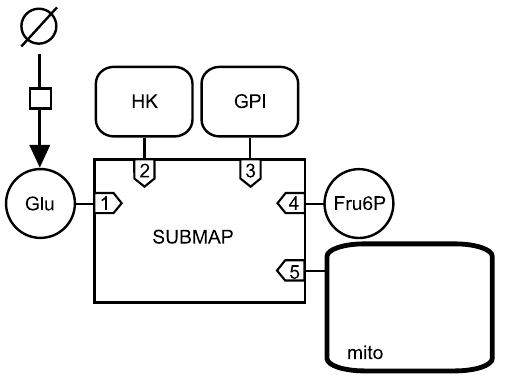
Figure 2.23: Example of a submap with contents